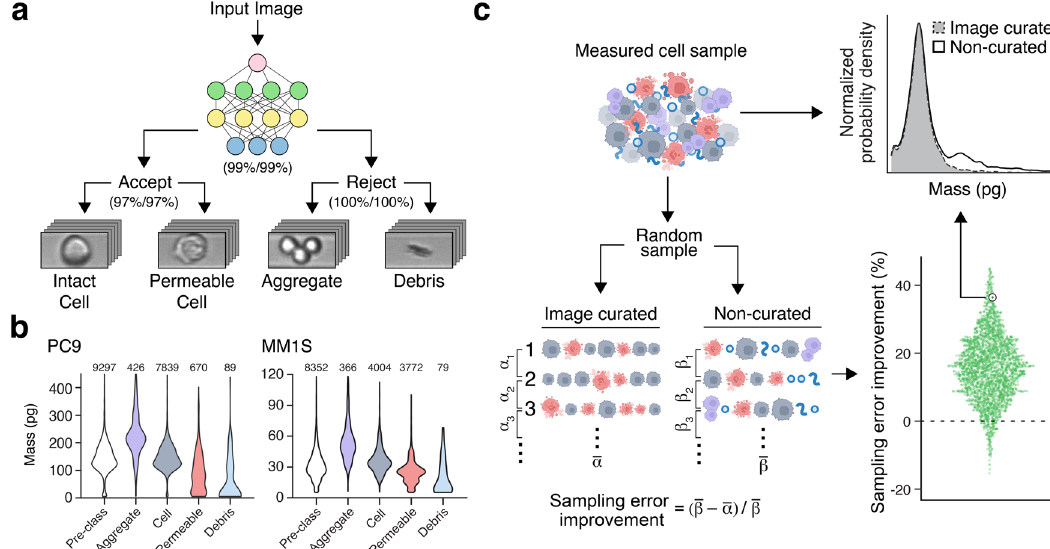
Fig. 3 Image annotation of mass data improves measurement fi delity. a Schematic representation of the multi-step image classi fi cation approach implemented in the work fl ow depicted in Fig. 1. An input image is fi rst classi fi ed as accepted or rejected with a binary CNN classi fi er, and subsequently, all accepted particles are classi fi ed as either an intact or permeable cell and all rejected particles are classi fi ed as either an aggregate or debris with two additional binary CNN classi fi ers. The inset images are representative of each class. The parenthetical percentages listed at each binary decision node indicate the cross-validated model performances, listing the precision and recall values, respectively (Methods). b Violin plots showing the mass distributions for a full population of cells without image classi fi cation (white) as well particles within the population that were classi fi ed as aggregates (purple), intact cells (gray), permeable cells (pink), or debris (blue) for a human lung cancer cell line model (PC9) and a human multiple myeloma cell line (MM1S). c Single-cell image classi fi cation reduces the noise in mass response signal by reducing the sampling error. As a demonstration, we randomly sample 1000 cells 100 times from a measured condition with and without image curation and calculate the mean mass response within these two sets representing the sampling error with and without image curation. When this is repeated for all the measurements presented in this paper, including 3222 measured conditions across 13 different instruments, we fi nd that image curation reduces the sampling error by 16.2% on average. An example pair of mass distributions with (gray) and without (white) image curation is shown, indicating the presence of cell aggregate and debris populations in the original measurement set, which are subsequently removed by the image curation